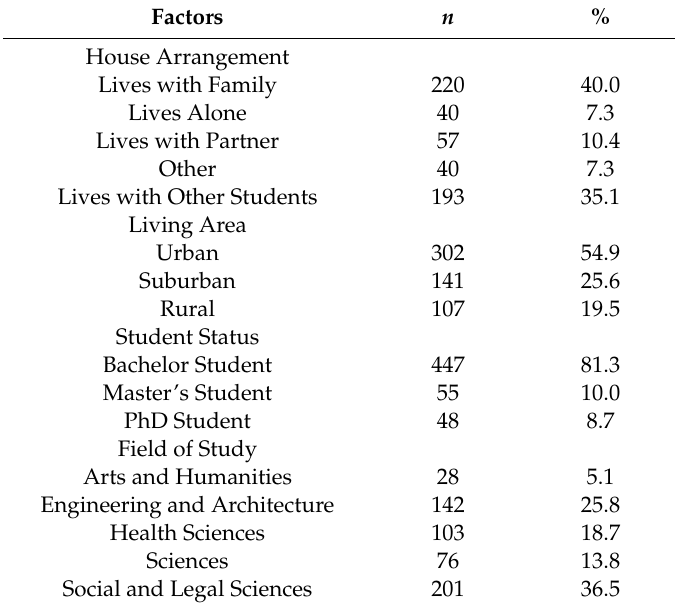
Table 1. Environmental and academic characteristics of the sample ( n = 550).